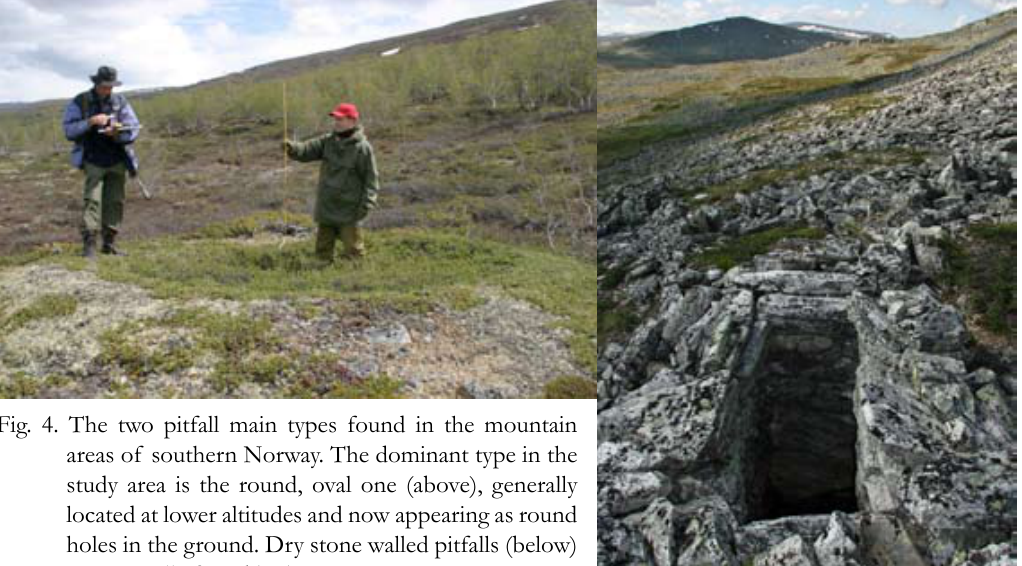
Fig. 4. The two pitfall main types found in the mountain areas of southern Norway. The dominant type in the study area is the round, oval one (above), generally located at lower altitudes and now appearing as round holes in the ground. Dry stone walled pitfalls (below) are generally found higher up in open mountain areas (Photo: Per